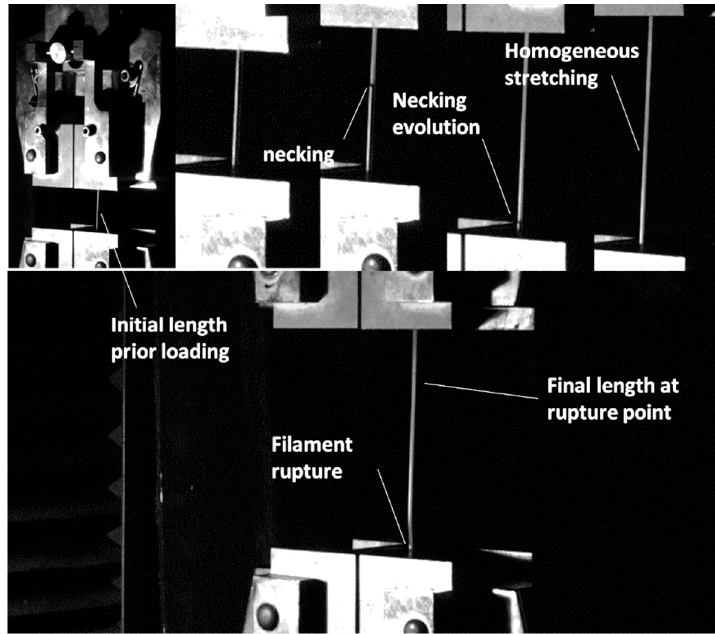
Figure 5. Typical stress–strain curves of as-received four replicates of PC filament.